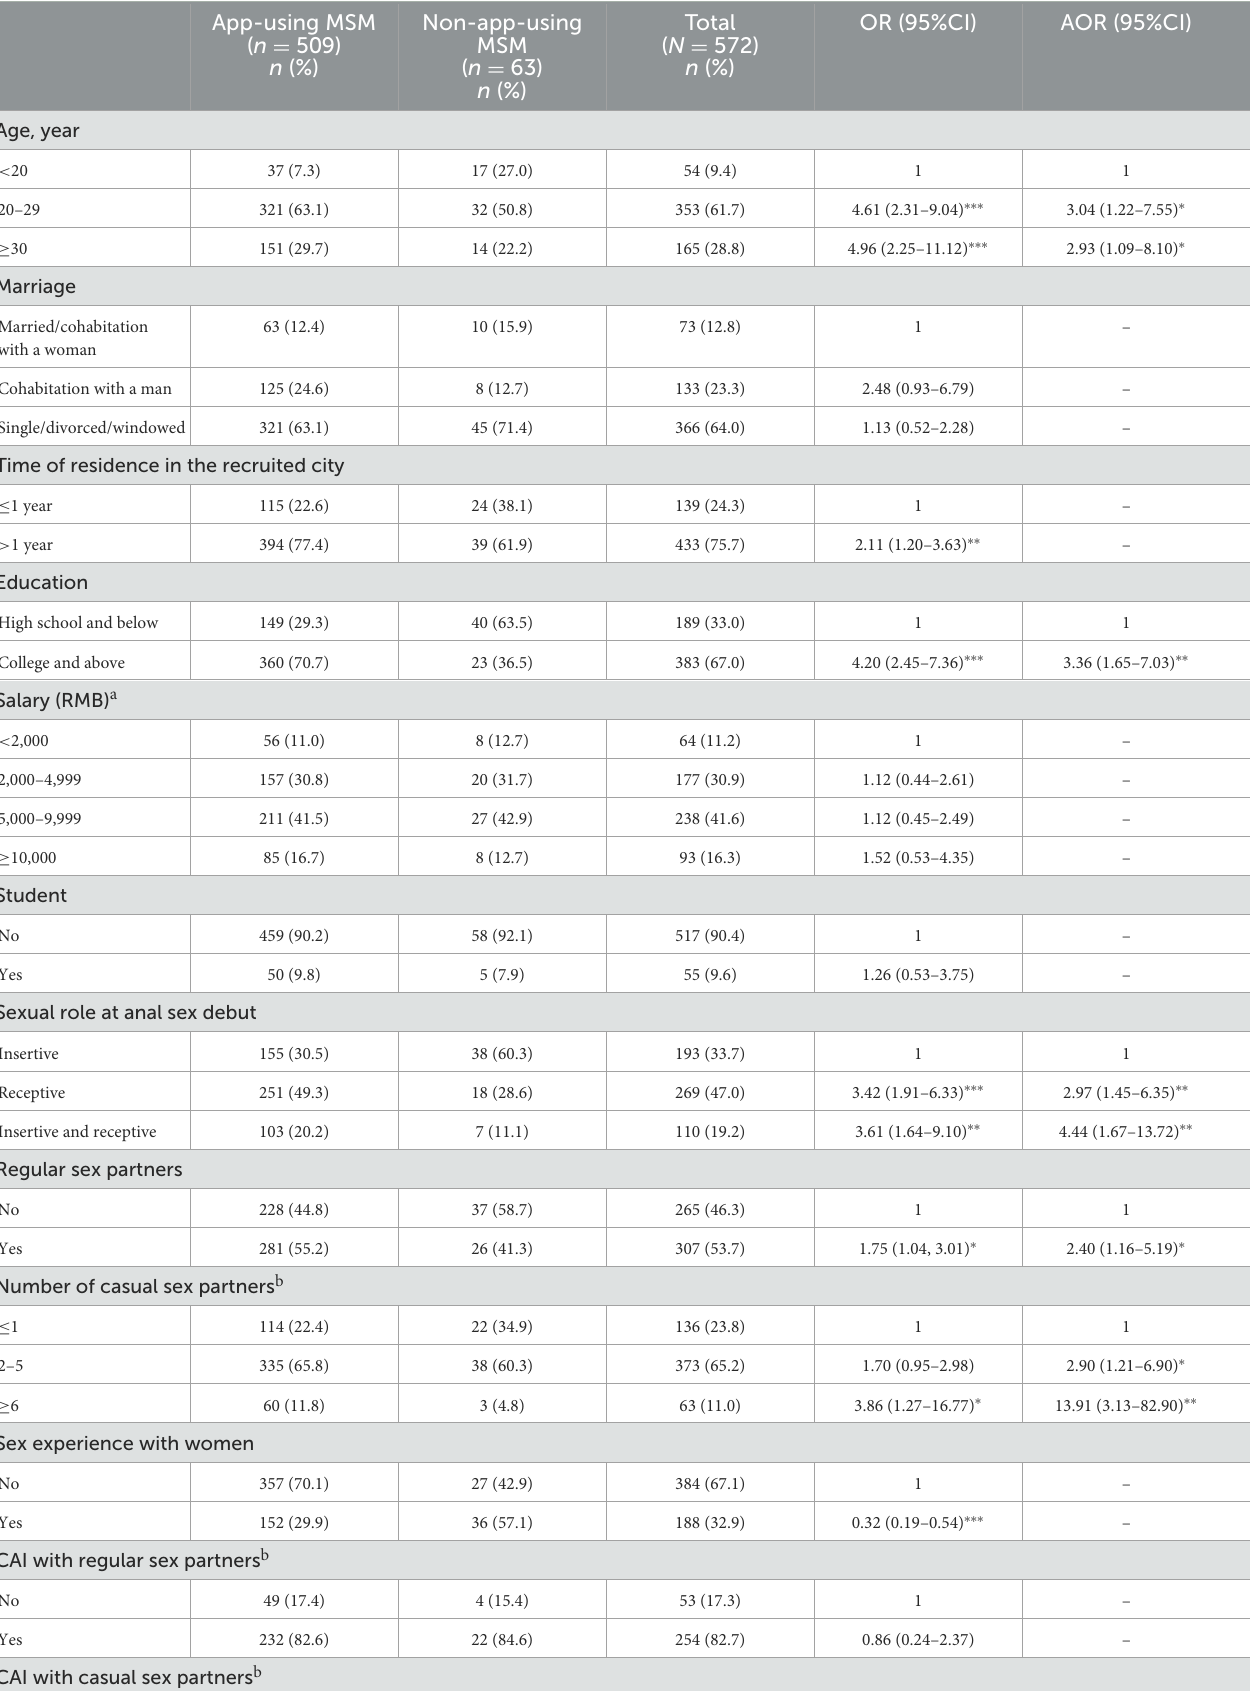
TABLE 1 Univariate and multivariate logistic analyses of characteristics of GSN app users and non-app users ( N = 572). App-using MSM ( n =